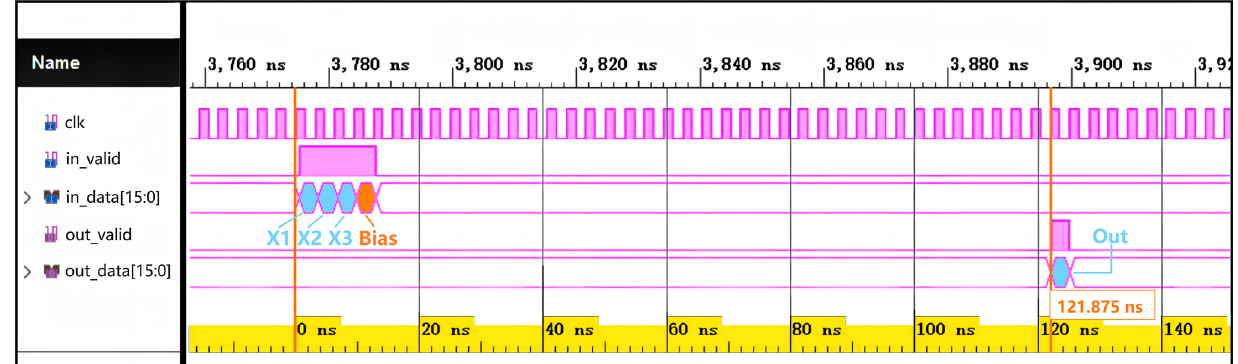
Fig. 14 FPGA timing simulation of the full neural network